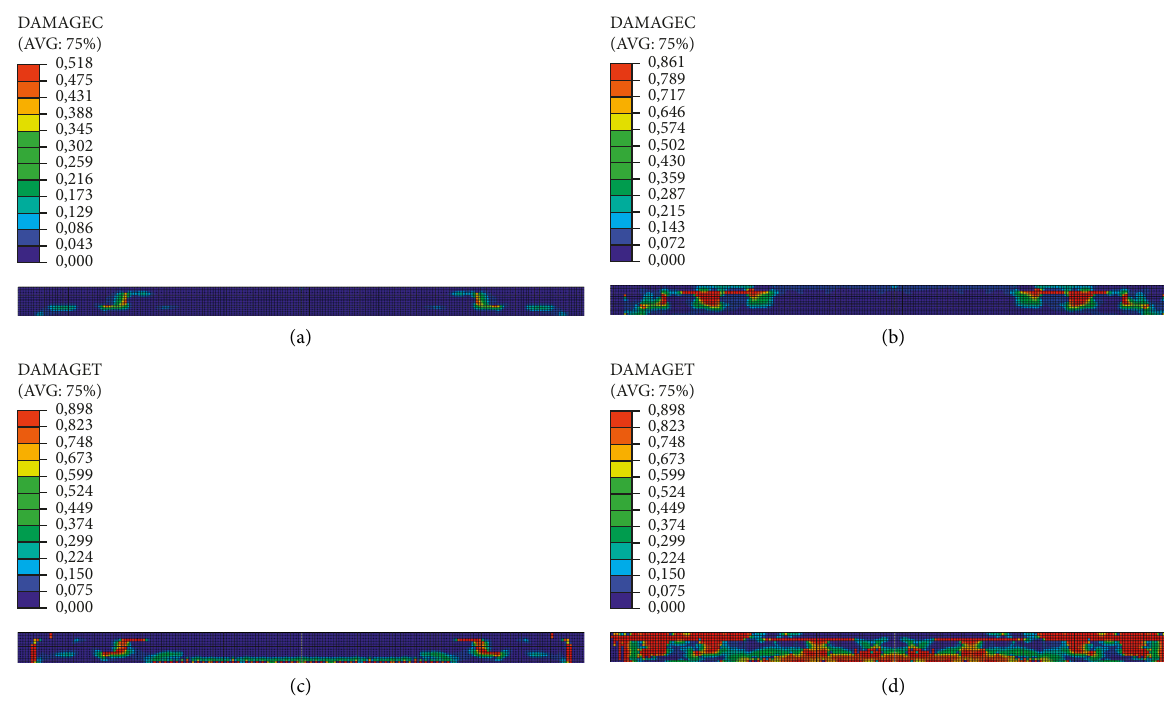
Figure 18: Damages in the UHPC layer. (a) Compressive damages in deck under 70% of the ultimate load. (b) Compressive damages in deck under the ultimate load. (c) Tension damages in deck under 70% of the ultimate load. (d) Tension damages in deck under the ultimate